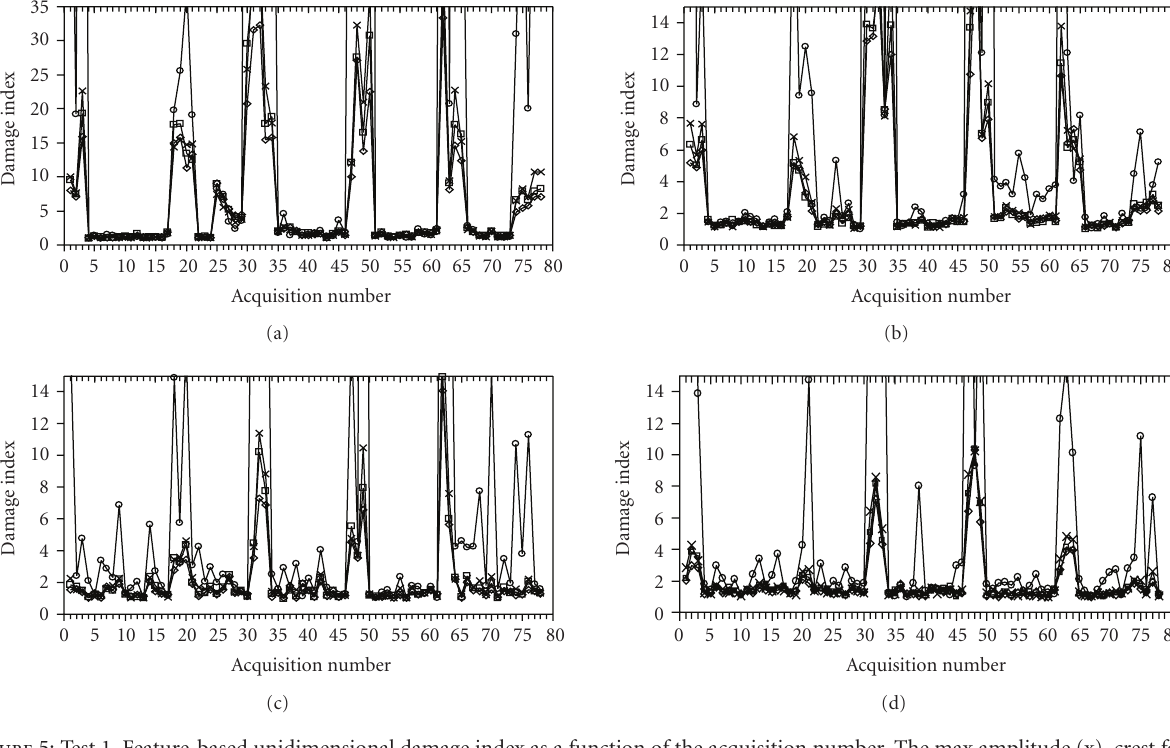
Figure 5: Test 1. Feature-based unidimensional damage index as a function of the acquisition number. The max amplitude (x), crest factor (o), peak-to-peak ( (cid:2) ), and the RMS ( ♦ ) of the wavelet coe ffi cient vector are plotted for the (a) high frequency components and (b) low frequency components of the time waveforms acquired with the central pair transducers, and for the (c) high frequency components and (d) low frequency components of the time waveforms acquired with the gage side transducers.